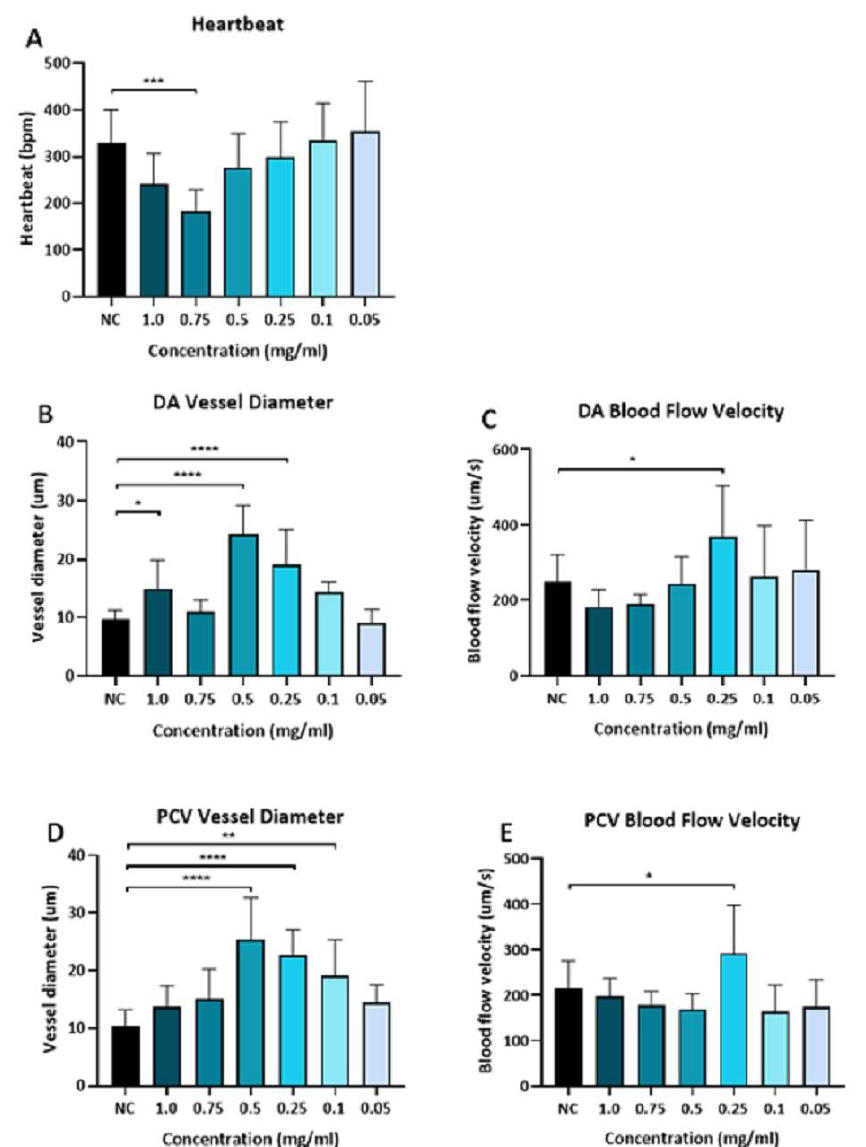
Figure 3. Cardiac function assessment of unloaded PLGA-PEG-PLGA. Cardiac function assessment of heart heartbeat, the dorsal aorta (DA) and posterior cardinal vein (PCV) vessel diameter, and blood flow velocity of the zebrafish embryos at 72hr post-fertilizing (hpf) treated with (0.75, 0.5, 0.25, 0.1, and 0.05 mg/mL) unloaded PLGA-PEG-PLGA NPs. ( A ) Heartbeat of embryos exposed to different concentrations of unloaded PLGA-PEG-PLGA NPs, a significant reduction in the heartbeat of the group which was treated with unloaded PLGA-PEG-PLGA NPs (0.75 mg/mL). ( B ) DA vessel diameter of embryos exposed to different concentrations of unloaded PLGA-PEG-PLGA NPs, vessel diameter showed to be enlarged significantly in groups of (1.0, 0.5, and 0.25 mg/mL) ( C ) DA blood flow velocity of embryos exposed to different concentrations of unloaded PLGA-PEG-PLGA NPs, blood velocity was increased significantly in the unloaded PLGA-PEG-PLGA NPs (0.25 mg/mL) group. ( D ) PCV vessel diameter of embryos exposed to different concentrations of unloaded PLGA-PEG-PLGA NPs, the vessel diameter showed to be enlarged in groups treated with unloaded PLGA-PEG-PLGA NPs (0.5, 0.25, 0.1 mg/mL). ( E ) PCV blood flow velocity of embryos exposed to different concentrations of unloaded PLGA-PEG-PLGA NPs, the blood velocity showed to be increased significantly in the unloaded PLGA-PEG-PLGA NPs (0.25 mg/mL) group. * = p < 0.05, (**) = p < 0.01, (***) = p < 0.001, (****) = p <0.0001.